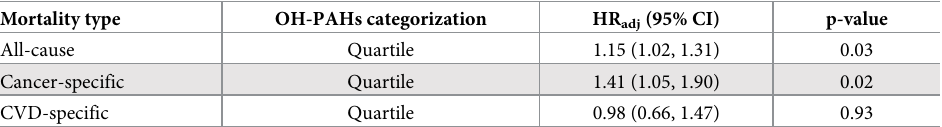
Table 5. Joint effect of OH-PAHs a on mortality outcomes b using quantile